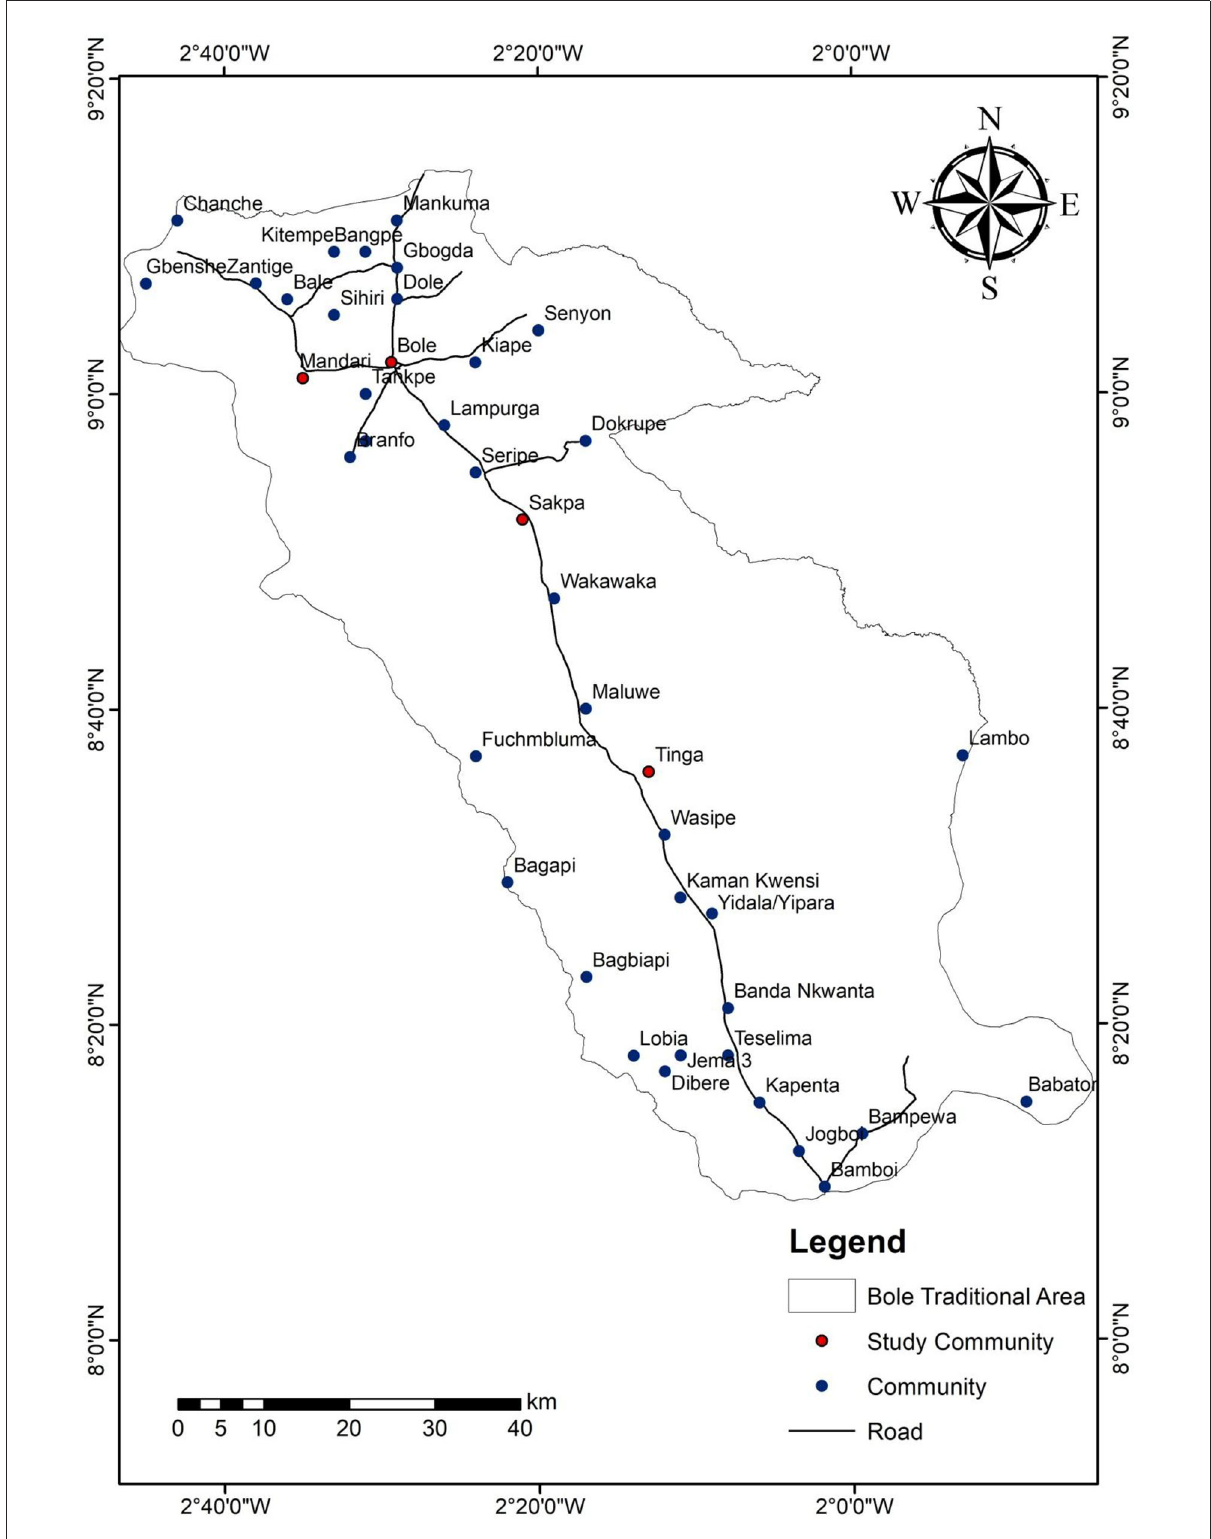
FIGURE2 Map of Bole traditional